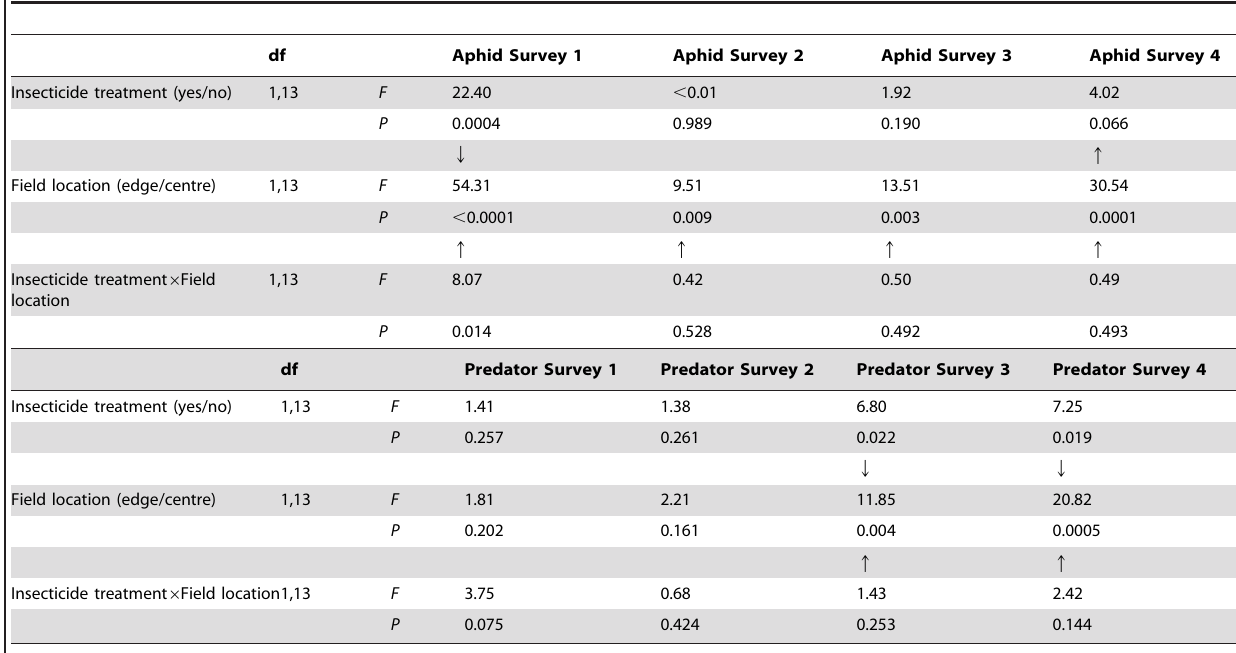
Table 5. Mixed effects model statistics for temporal changes in aphid abundance and predator abundance with the explanatory variables insecticide treatment, flied location and the interaction of insecticide treatment and field